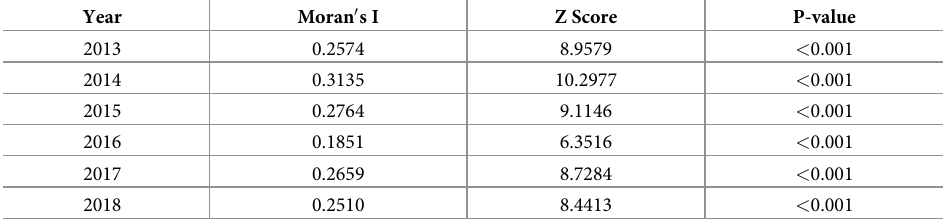
Table 2. The results of the spatial autocorrelation test on HFMD cases in Qingdao Province,